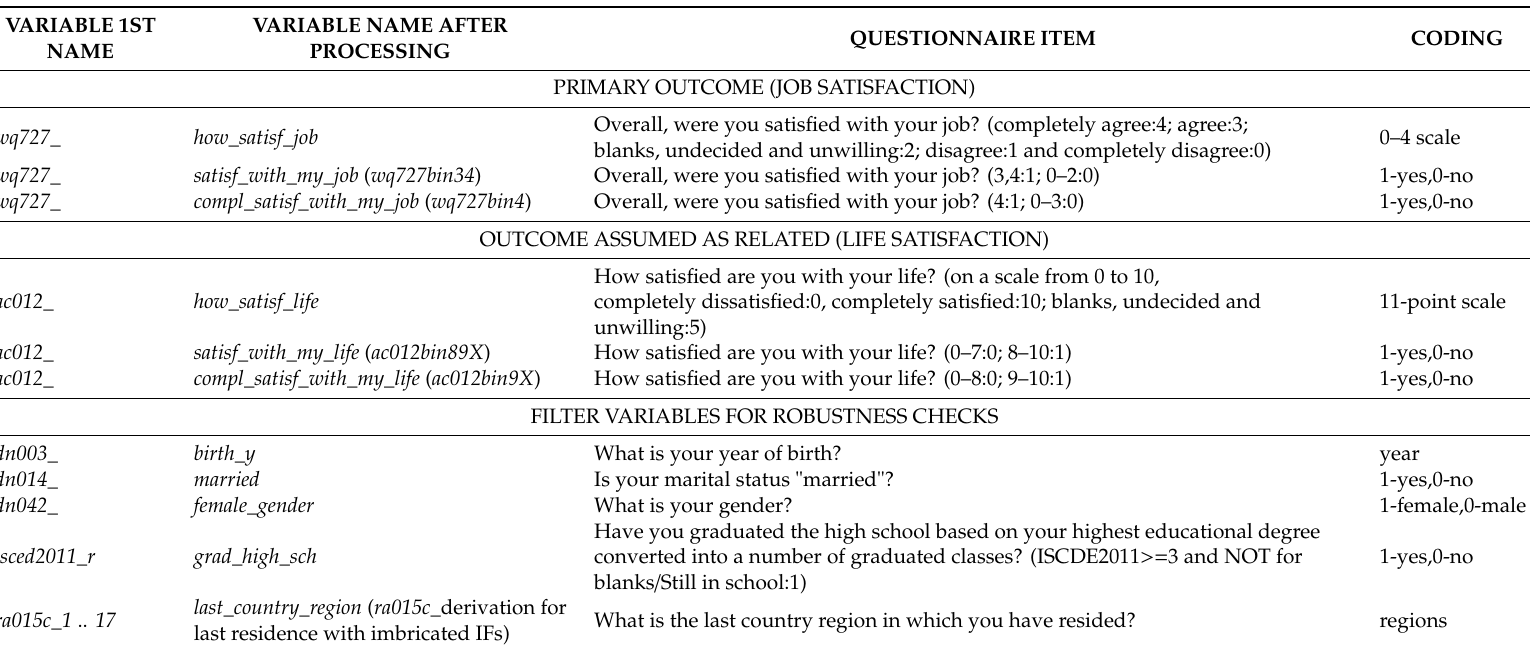
Table A1. Questionnaire items mostly selected after the first round mining, then renamed and processed (the extended set). VARIABLE